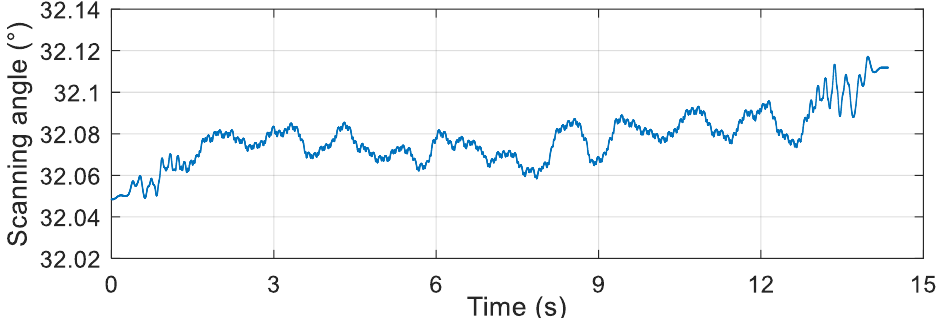
Figure 8. Simulation turntable and the placement of the measurement device.